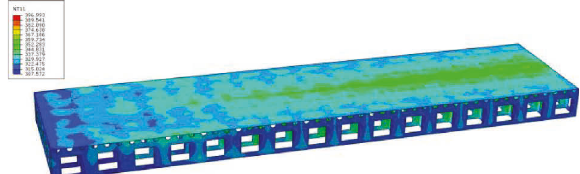
Figure 7: Temperature nephogram of the tool at the end of the cooling.